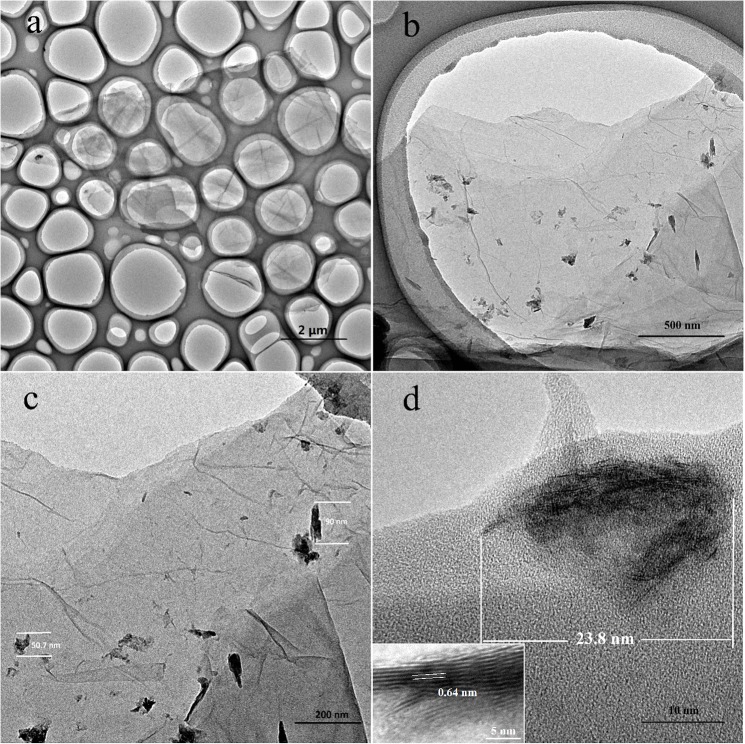
TEM images of MoS2 NSs/rGO.